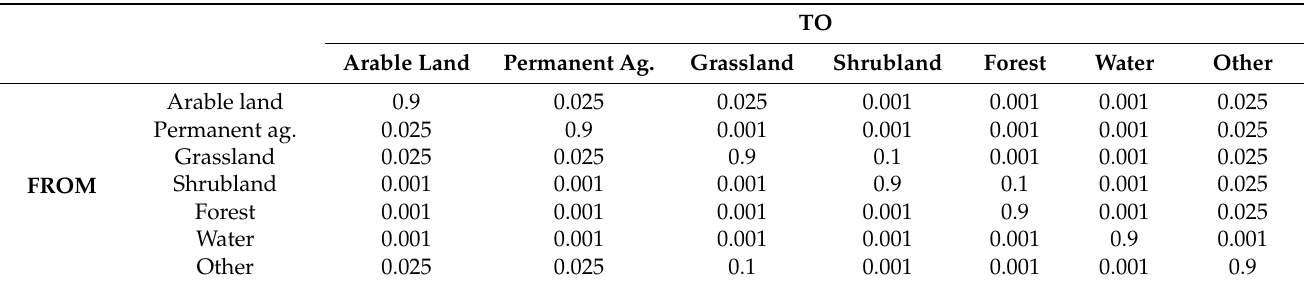
Table 3. Land cover transition probability